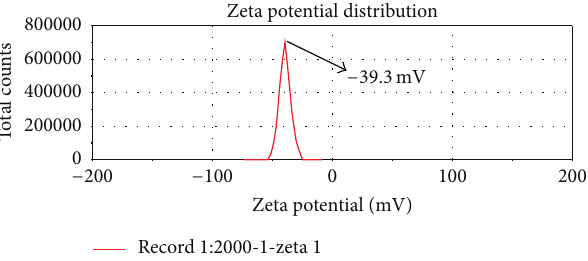
Figure 1: ESD nanosilver preparation system framework.